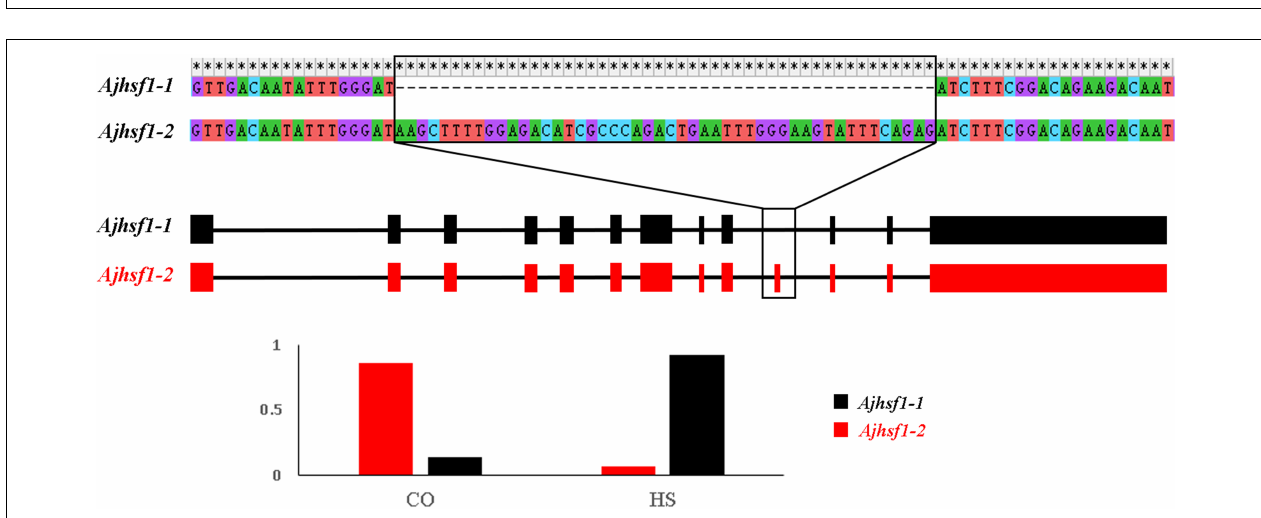
FIGURE 5 | GSEA applied to validate the significantly enriched pathways.